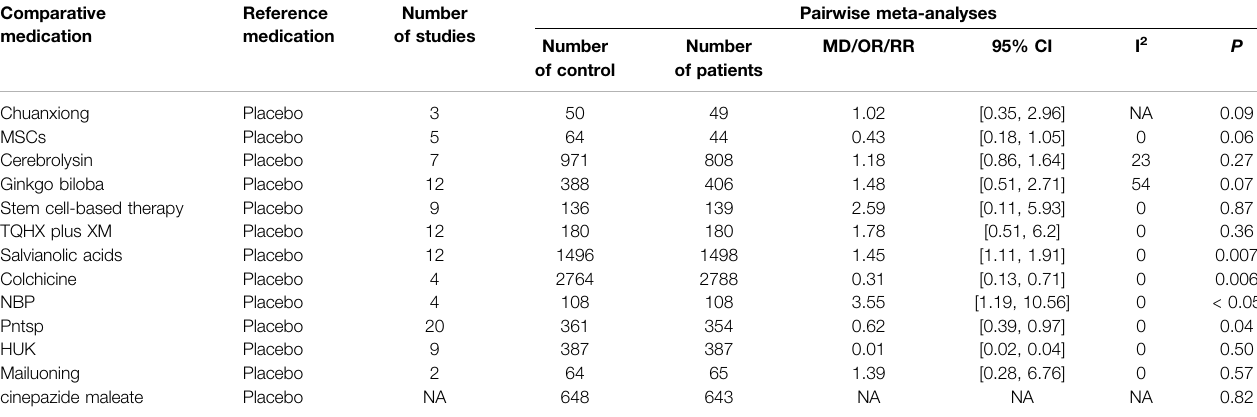
TABLE 9 | Results of pairwise meta-analyses for AE. Comparative